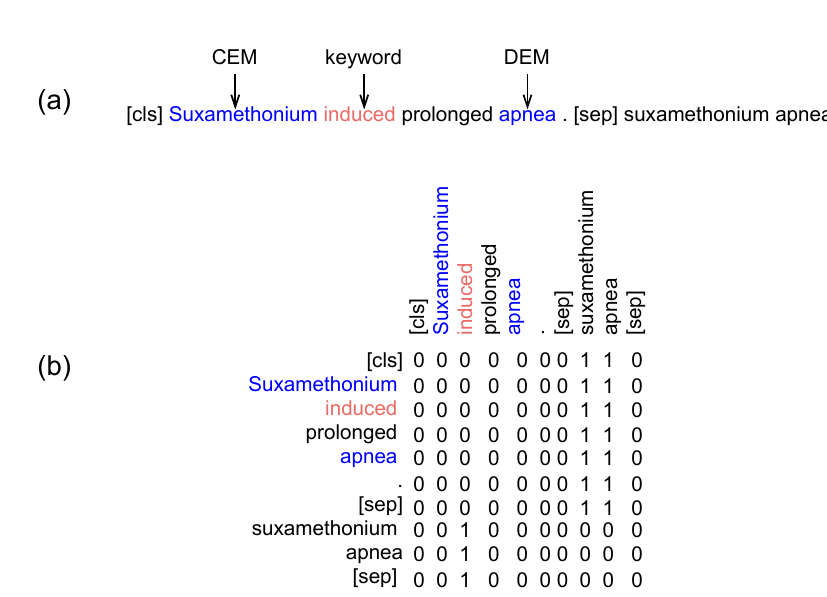
Figure 3. Self-attention masks. ( a ) A sample with a CID relation. ( b ) The attention mask matrix associated with the sample in ( a ). Each token i is assigned with a binary vector (i.e., row i in M AttMsk ) that specifies which tokens it attends to. If the j th element at row i is zero, token j is not attended by i ; otherwise, j is attended by i